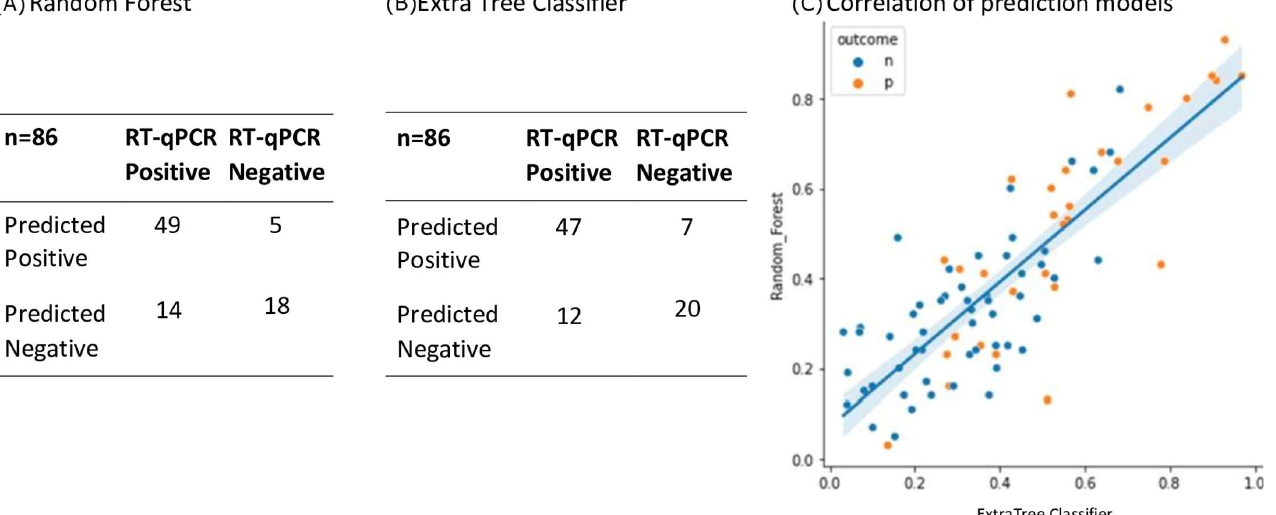
Figure 5. Performance characteristics of ML algorithms. Of the 215 sample spectra, 129 (60%) were randomly selected to form the training set. It was found that Random Forest ( A ) and Extra Tree Classifier ( B ) ML algorithms performed the best. A testing set of 86 samples (which had been independent of the training set) were run on the two algorithms and the results shown in the two confusion matrices (Panel ( A , B ) respectively). Agreement with RT-qPCR classification was 78%, p < 0.00001 for both models. There was a strong correlation between both models on sample scoring for these validation test samples (panel ( C ), line represents linear correlation r 2 =0.681 and shading the 95% confidence limits. Blue dots ( n ) = negative, orange dots ( p ) =